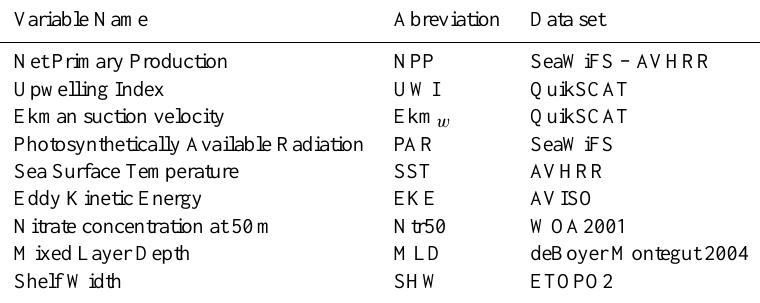
Table 1. List of variables and sources of the